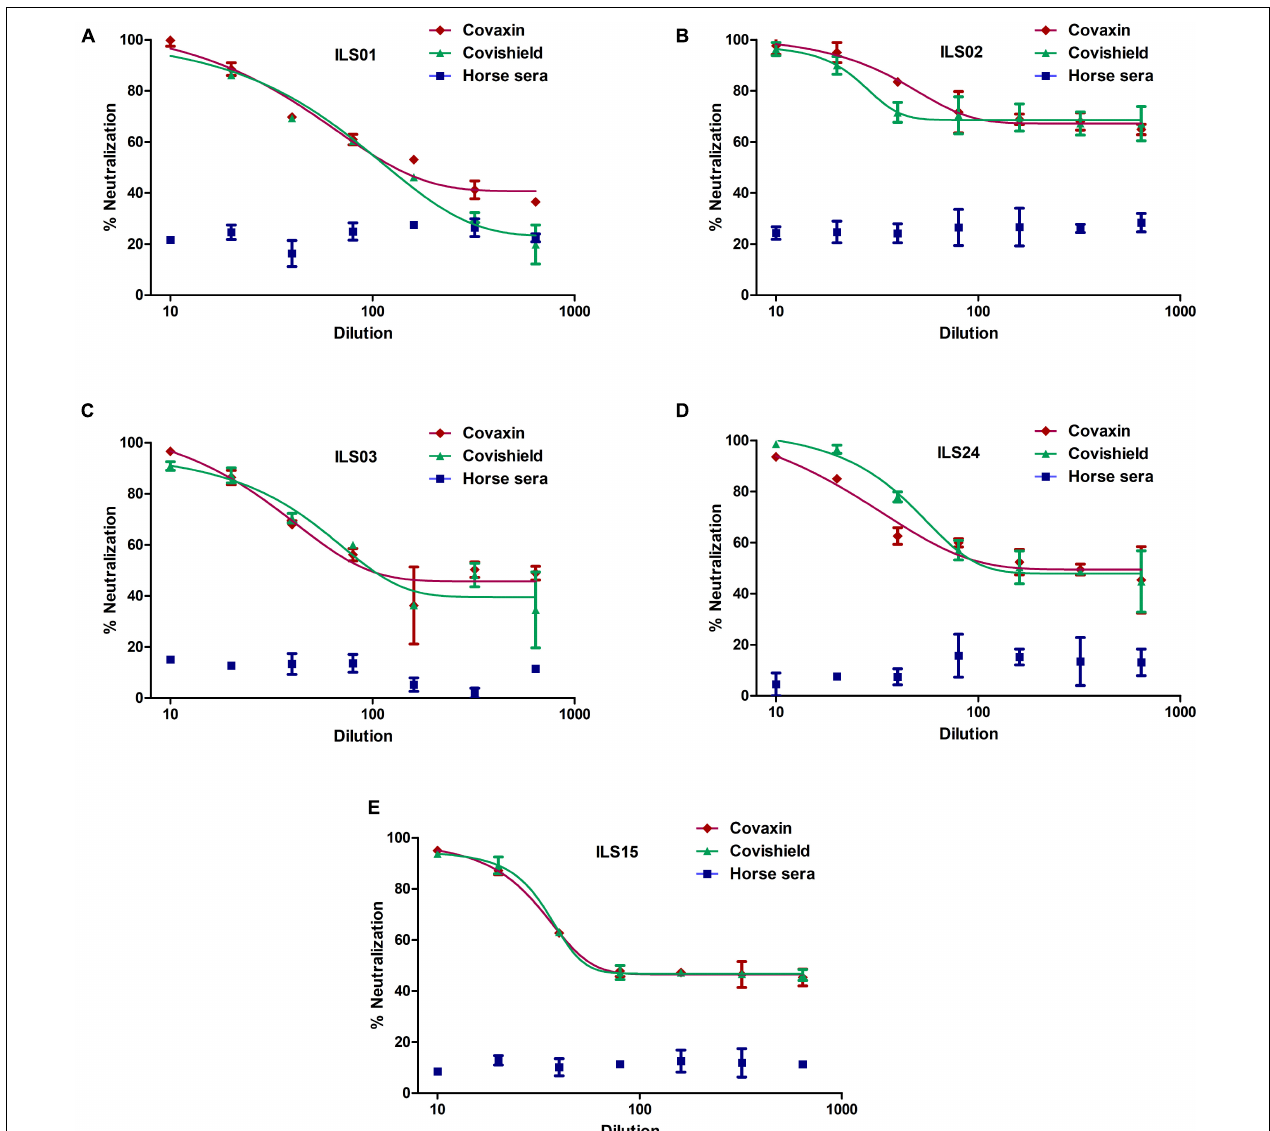
FIGURE 5 | Neutralization potential of sera obtained from vaccinated individuals: The respective isolates were subjected to micro-neutralization assay using the sera obtained from Covaxin and Covishield vaccinated individuals to determine the neutralization potential of the post-vaccination sera against the respective isolates. The dose-response curves were fitted using a non-linear regression model using the GraphPad software Prism 5. (A–E) Neutralization efficiency of the respective vaccinated sera against the five isolates. Horse sera were used as a negative control.